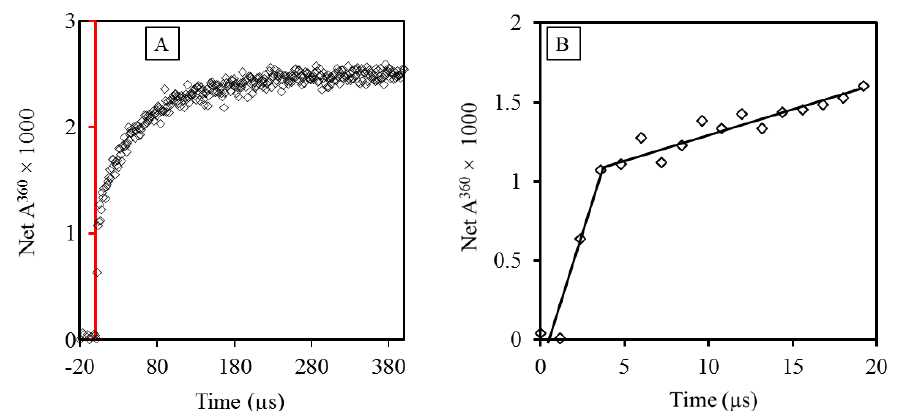
Figure 2. Pulse radiolysis results showing two simultaneous reactions of insulin with ascorbate. ( A ) The curve shows the growth of Asc • at 360 nm, with the red line indicating the time of pulse. ( B ) Analysis of the kinetics of Asc • formation shows two processes closely following the pulse. The pseudo first-order rate constants of the reactions were derived by radiolysis of solutions with different concentrations of HAsc −